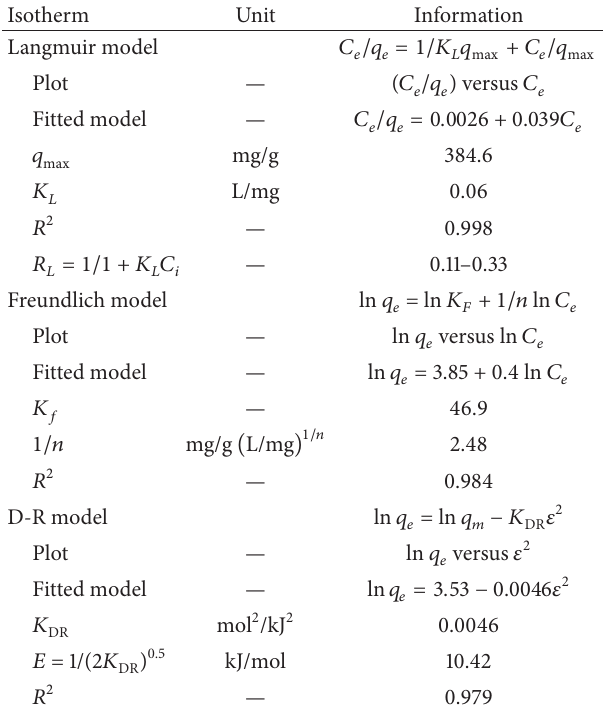
Table 4: Results of OII dye adsorption isotherm modeling. Isotherm Unit Information Langmuir